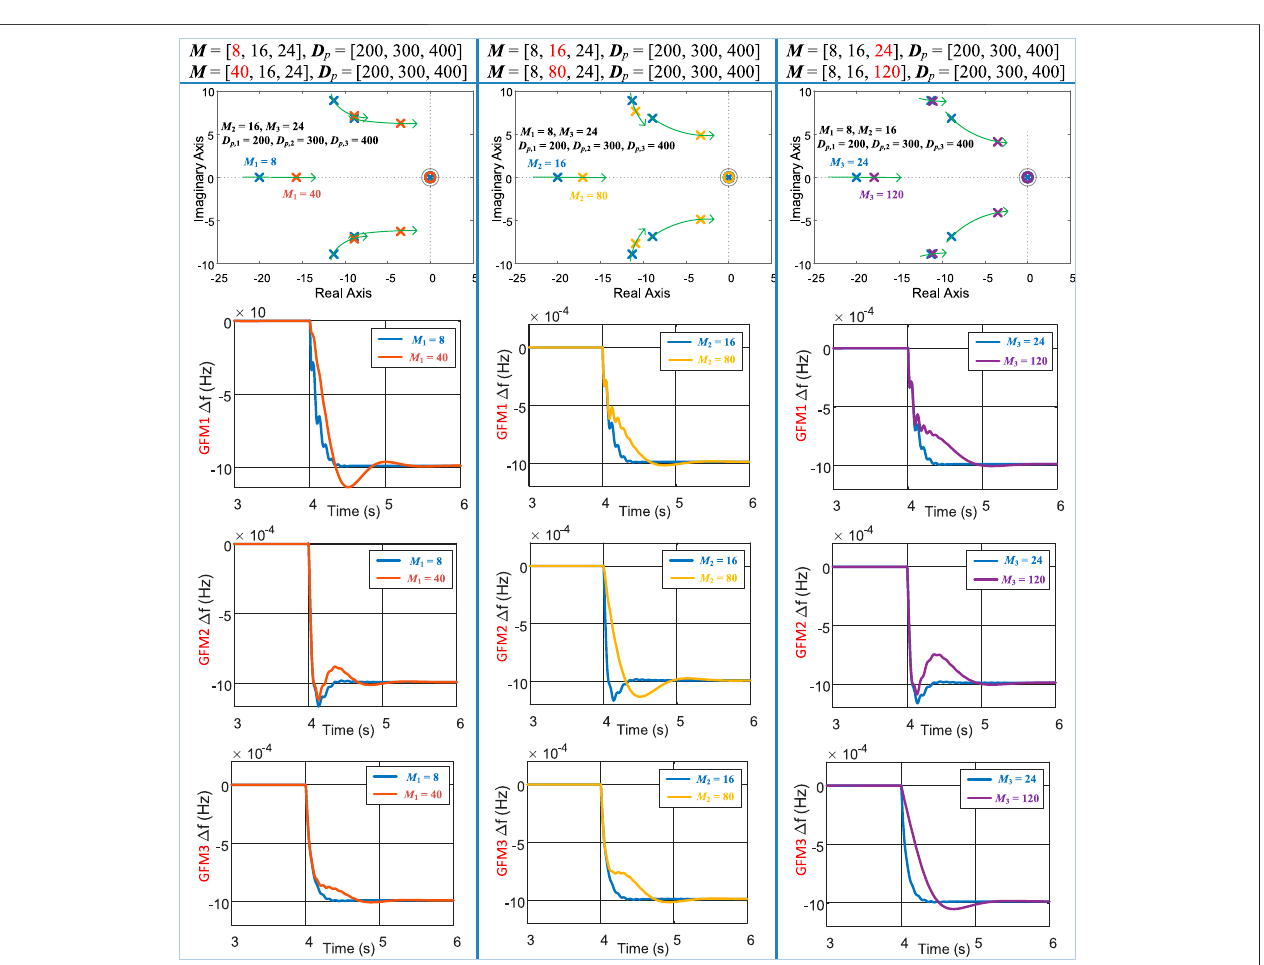
FIGURE 6 | Frequency response when the inertia changes.